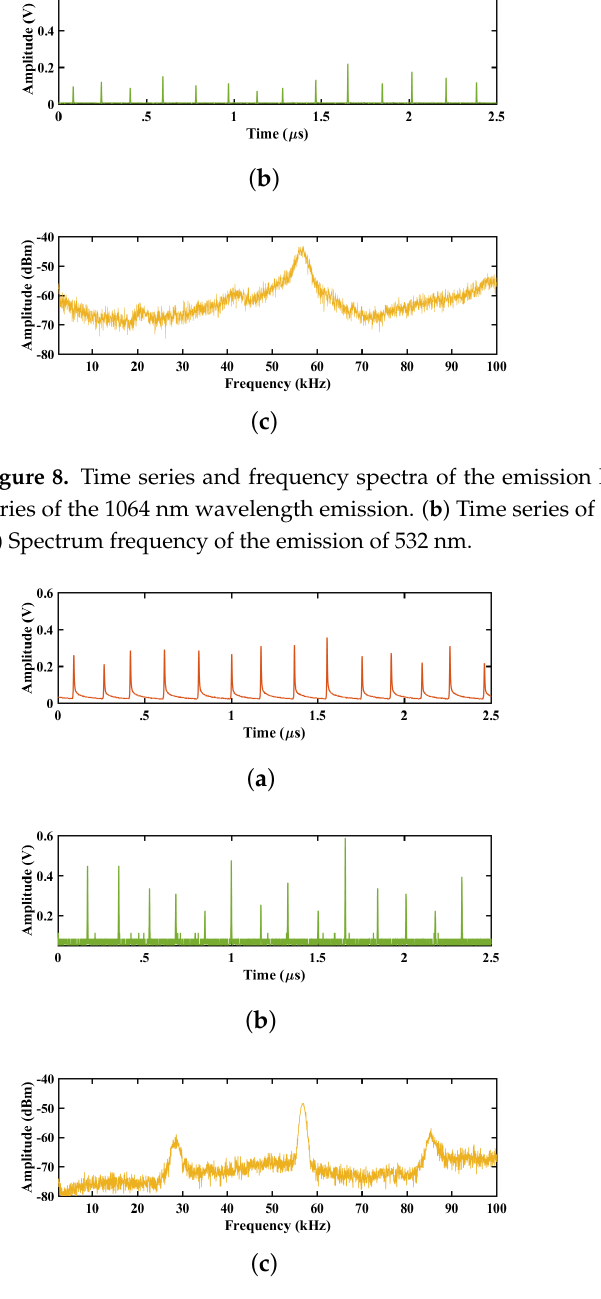
Figure 9. Time series of the laser emission with the modulation parameters A m = 7.5 V and f m = 57 kHz. ( a ) Time series of the 1064 nm wavelength emission. ( b ) Time series of the wavelength radiation of 532 nm. ( c ) Spectrum frequency of the emission of 532